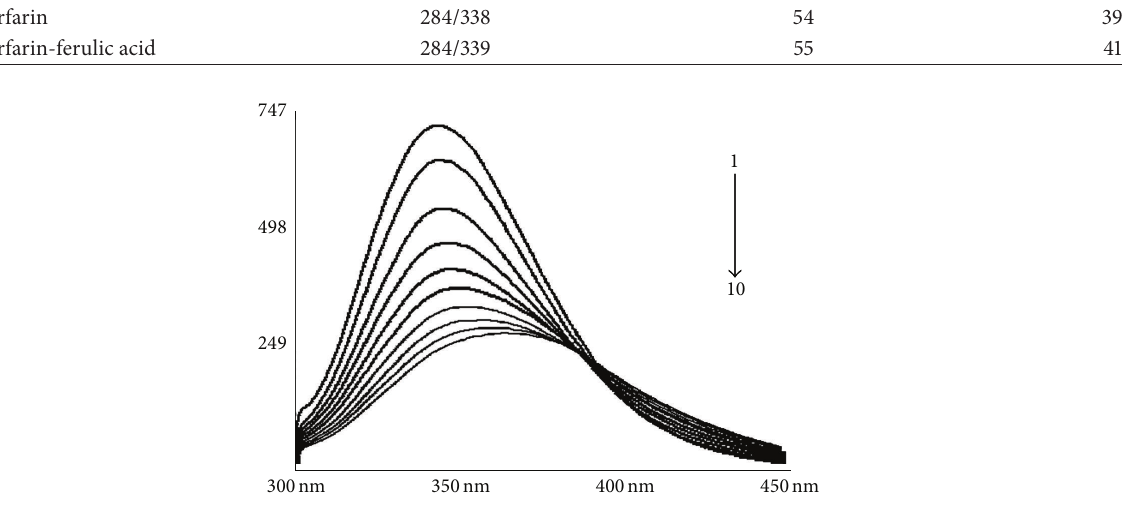
= 4×10 −6 M, 𝐶 = 6×10 −6 M, ( ferulicacid ) HSA )